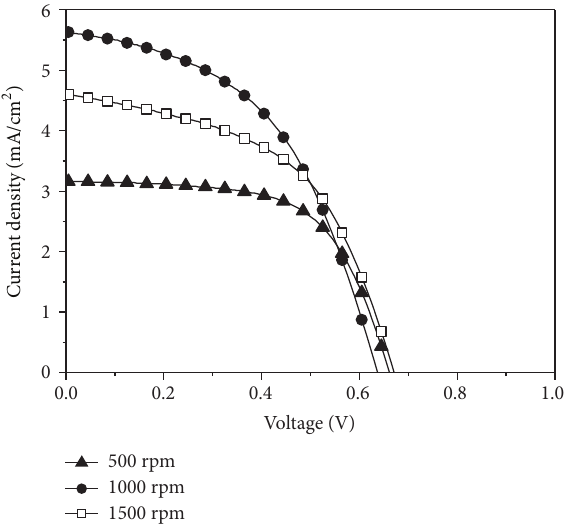
Figure 9: Lifetime of electrons of DSSCs sensitized by chlorophyll, anthocyanin, and cocktail